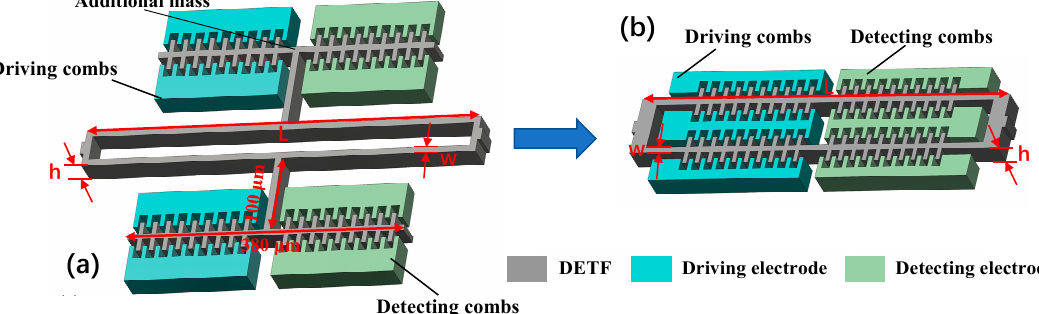
Figure 2. Structure design of DETF. ( a ) Conventional design with airfoil additional mass; ( b ) Improved design with no additional mass.